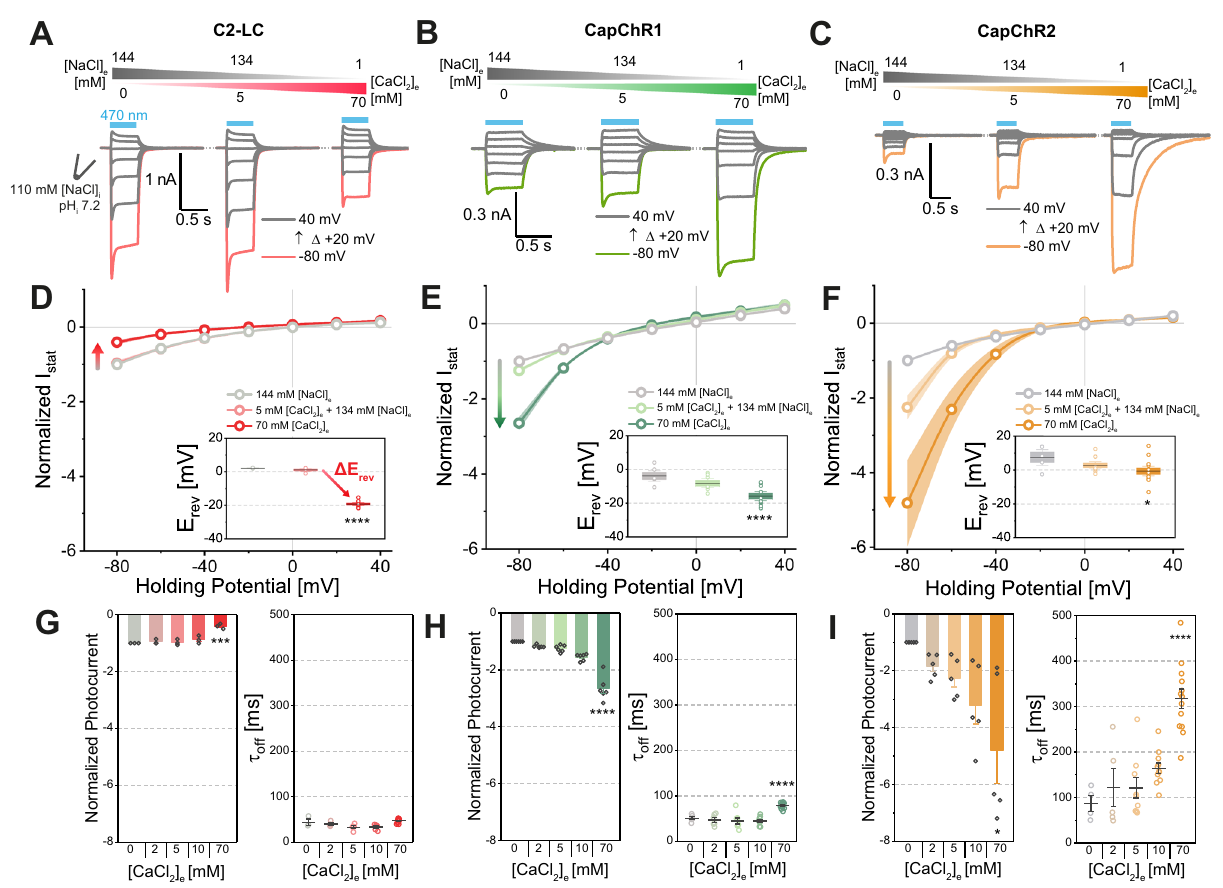
Fig. 3 | Calcium vs. sodium permeation in C2-LC, CapChR1 and CapChR2. A – C Representative photocurrents traces of C2-LC (red), CapChR1 (green) and CapChR2 (orange), respectively, recorded from − 80 to +40mV in 20mV steps at different calcium/sodium concentrations in ND7/23 cells (blue bar: illumination withsaturating,470nmlight;~1.9mW/mm 2 ). D – F I ( E )relationshipswithestimated reversal potentials (insets, Box middle line: Mean; Box outer edges±SEM; Box whiskers: 1.5×SEM) for the tested ChRs at the designated ionic conditions (mean±SEM, normalized to currents at − 80mV and 0mM [CaCl 2 ] e ). Dots repre- sent mean values and shading the SEM ( p values for D , E and G : C2-LC p =5.52×10 − 10 ; CapChR1 p =4.06×10 − 5 ; CapChR2 p =0.04). G – I Left: Normalized photocurrents at − 80mV holding potential and at the denoted [CaCl 2 ] e in the presence of sodium. Bars represent the mean±SEM and dots represent single